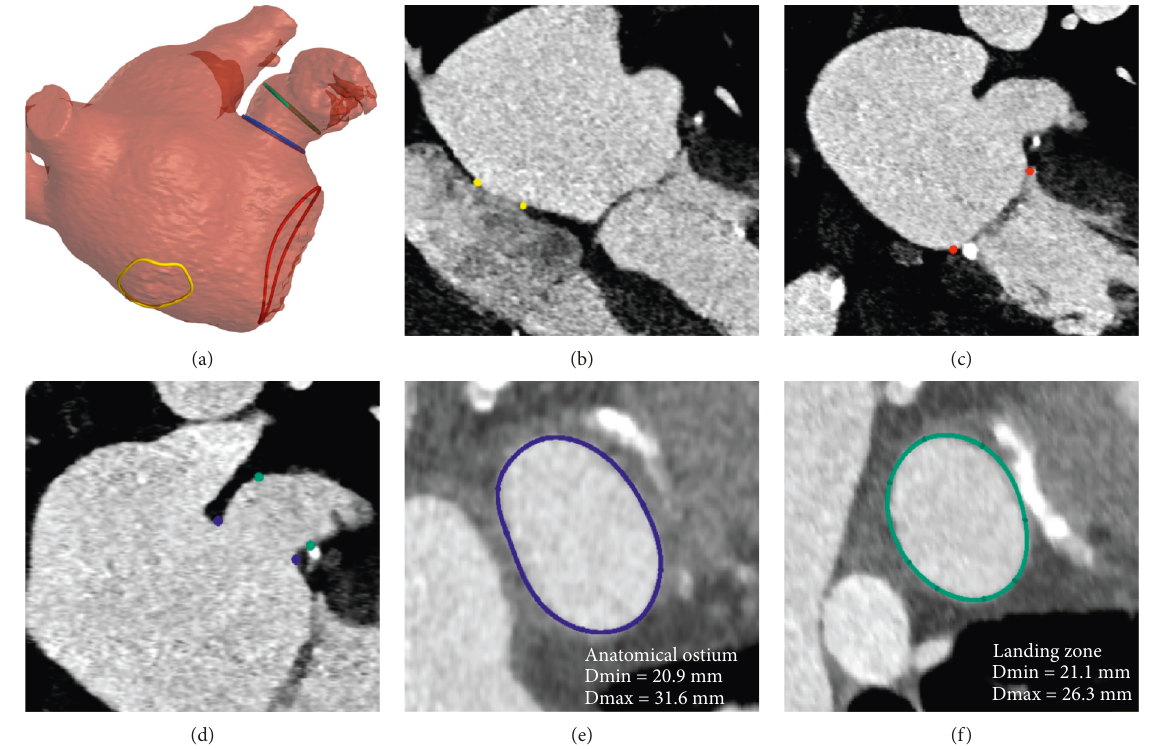
Figure 1: Anatomical structures and landmarks identified by the model. (a) 3D model reconstructed from the segmentation of the left atrium and left atrial appendage, where the landmarks of the anatomical ostium (blue), landing zone (green), fossa ovalis (yellow), and mitral annulus (red) are reported. (b) Fossa ovalis region indicated on the DICOM (yellow). (c) Mitral annulus indicated on the DICOM (red). (d) Anatomical ostium and landing zone indicated on the DICOM (blue and green, respectively). (e) Anatomical ostium plane. (f) Landing zone plane (Amulet